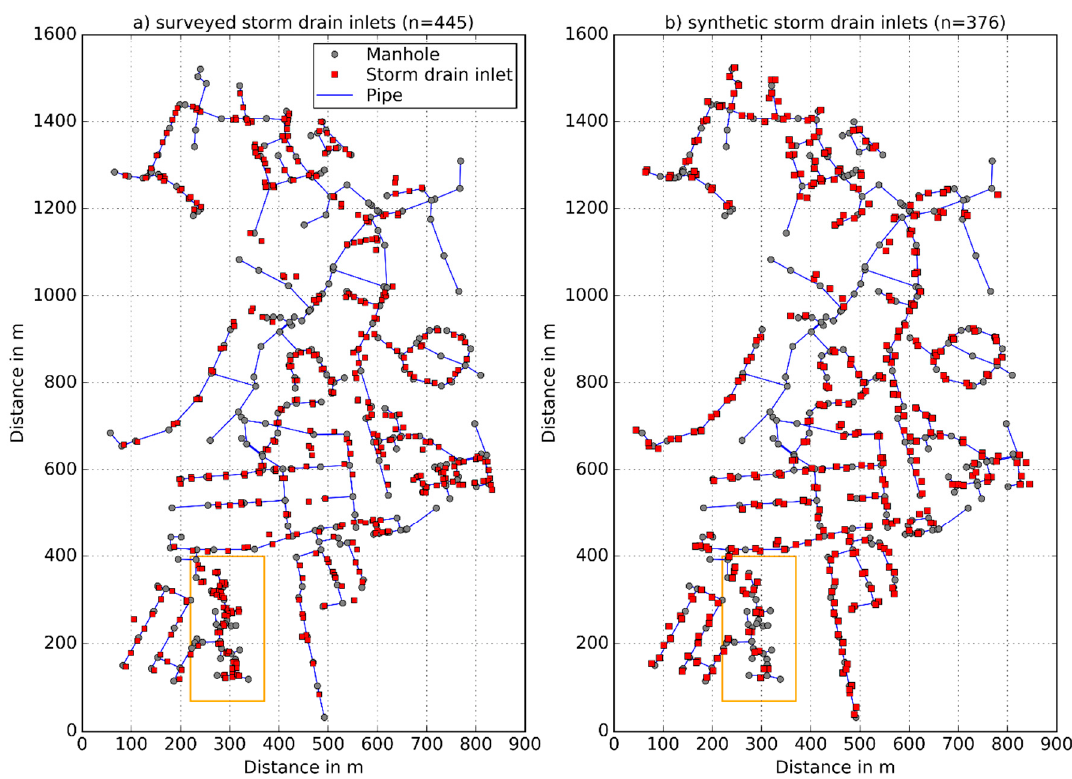
Figure 3. Surveyed storm drain inlet network ( a ) and synthetic storm drain inlet version 1 ( b ).